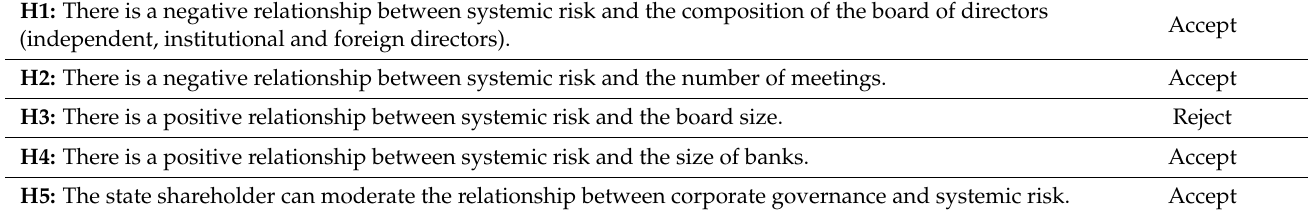
Table 7. Summary of the Key